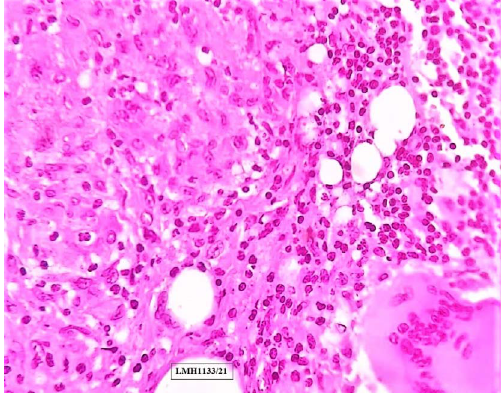
Figure 10. Hand E-stained slide [ (cid:1) 400 magni fi cation] showing epithelioid cell forming